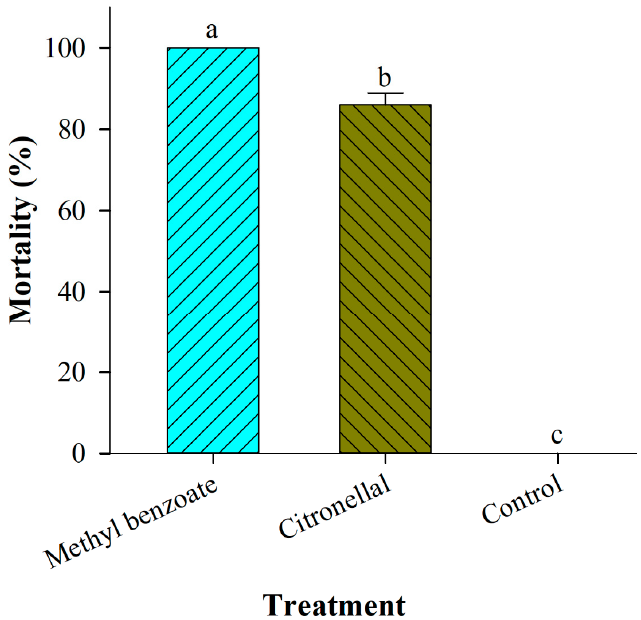
Figure 4. Mortality (%) of Plodia interpunctella adults contained within a large cardboard box (volume 96,000 cm 3 ) after a 24-h fumigation exposure to 0.01 μ L/cm 3 (i.e., 1 mL) of methyl benzoate (MBe) or citronellal. The control boxes contained untreated filter paper. Vertical bars represent mean percentage ± SE. Different lowercase letters above bars represent sig- nificant differences at p <